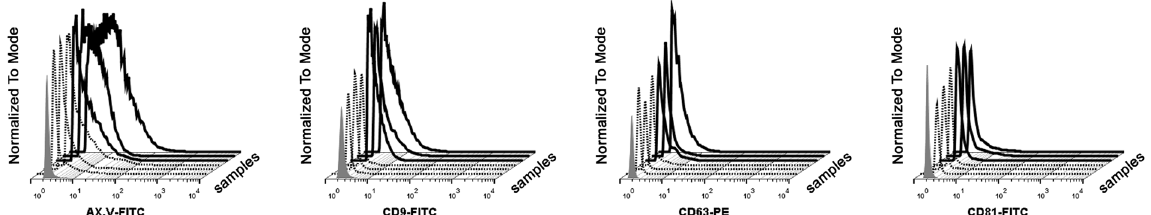
Figure 2. Flow cytometry detection of surface markers of human platelet free blood plasma extracellular vesicles (EVs) conjugated onto latex beads. EVs were isolated either by Total Exosome isolation kit (Life Technologies, by Thermo Fisher Scientific, Waltham, MA, USA) (empty histograms with dotted lines) or ultracentrifugation at 100,000 g (empty histograms with continuous lines) from three different human plasma samples, respectively. Antibody binding to BSA-coated latex beads is shown in gray histograms.